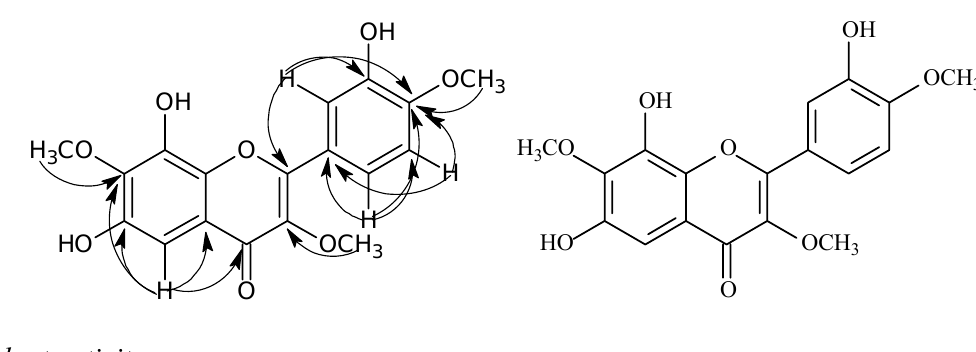
Figure 3. The key HMBC correlations of compound 2 .